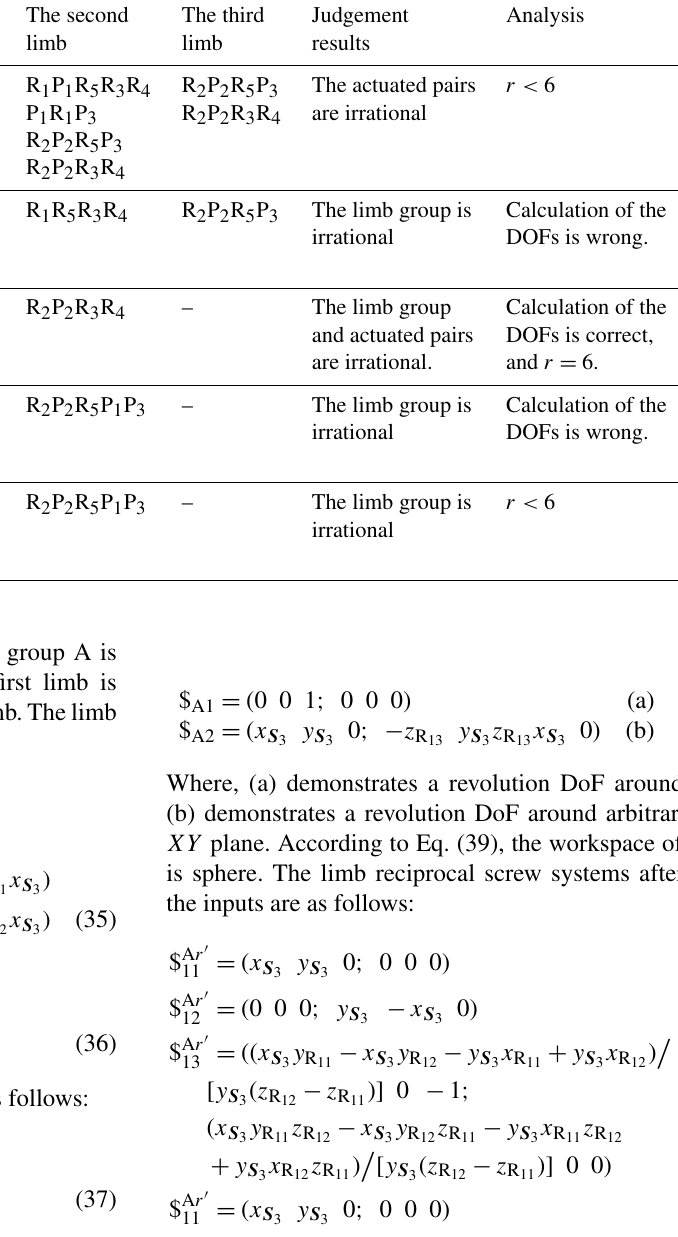
Table 1. Comparison of different inputs. The first The second The third Judgement Analysis limb limb limb results Limb group 1–4 R 7 H 1 R 6 P 1 R 5 R 3 R 4 The actuated pairs r <